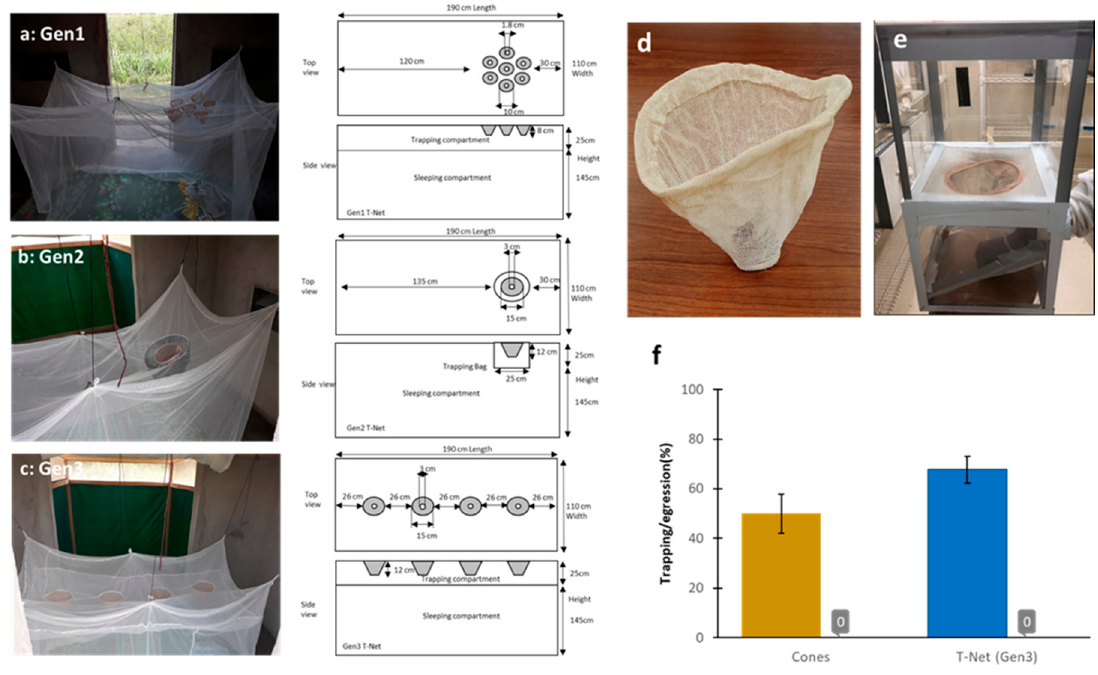
Figure 2. Different T ‐ Net designs and testing. ( a ) Generation (Gen) 1 T ‐ Net made of a circular aggregate of seven small cones, ( b ) Gen2 T ‐ Net made with one large cone fitted on a trapping bag ( c ) Gen3 T ‐ Net fitted with four large cones, ( d ) example of a knitted cone, ( e ) experimental tunnel apparatus to assess the trapping efficacy of a knitted cone, and ( f ) results obtained from the tunnel test for trapping efficiency of a large cone (on the left) and for the Gen3 T ‐ Net in a laboratory hut experiment (on the right). The histograms represent the trapping rates, the bars on top are the 95% confidence intervals, and “0” are the exit rates (= egression) in the absence of host cues.